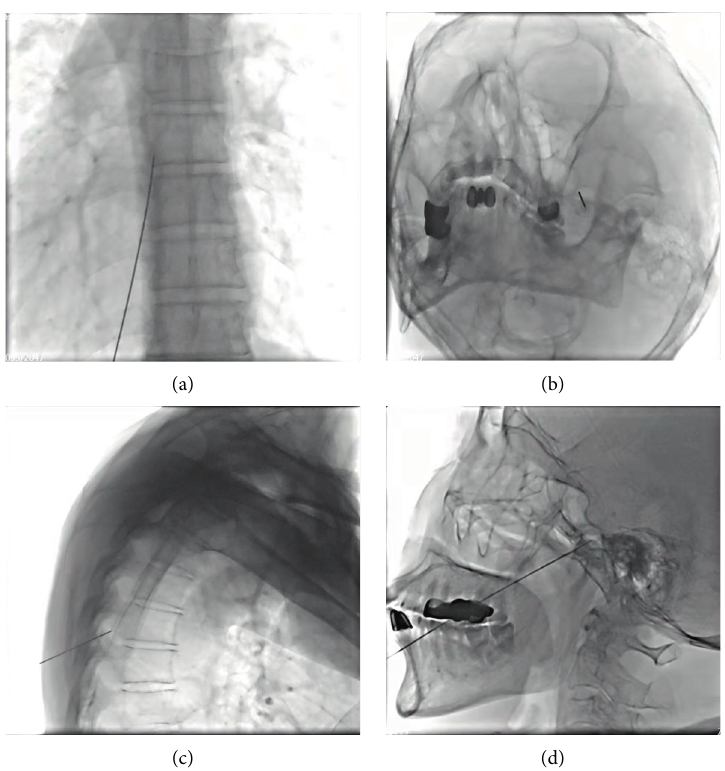
Figure 2: DSA guidance: DSA-guided puncture was used in each group to select a safe puncture route to avoid damage to blood vessels or lung tissue and clarify where the puncture needle would reach the target site (a, b). DSA-guided orthopantomogram of the puncture (c,